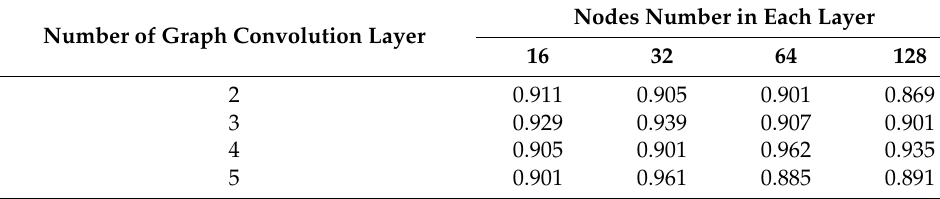
Table 5. The detection accuracy of different graph convolutional layers and nodes.